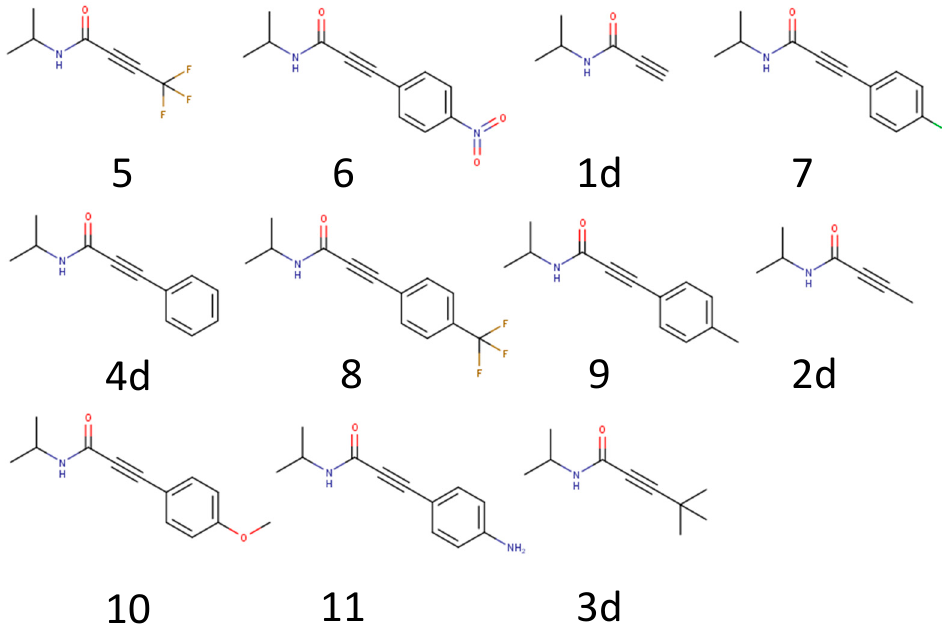
Figure 6. Example molecules to further test the influence of a warhead substitution pattern.